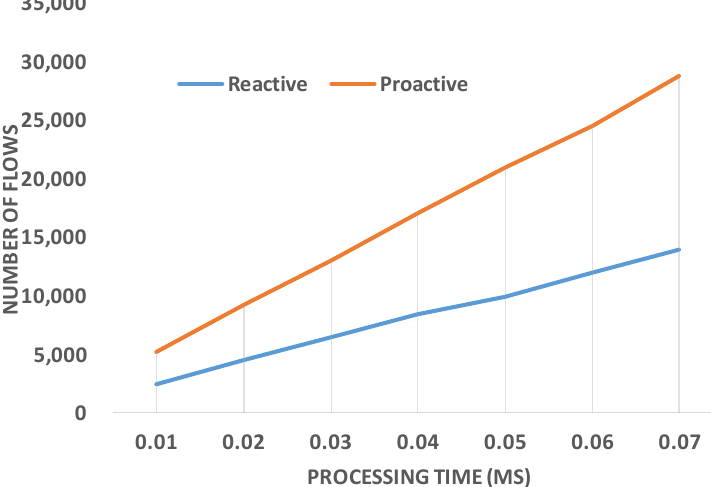
Figure 13. Two nodes ’ flow-rule exchange.